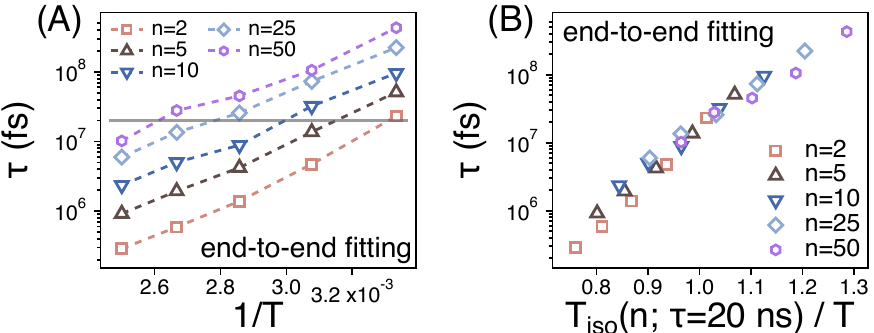
Figure 9. ( A ) The relaxation times ( τ ete ) of the orientational relaxation of strands of size n as functions of 1/ T ; ( B ) τ n as a function of the rescaled temperature. T ( n ; τ ete = 20 ns) is the temperature at which τ ete = 20